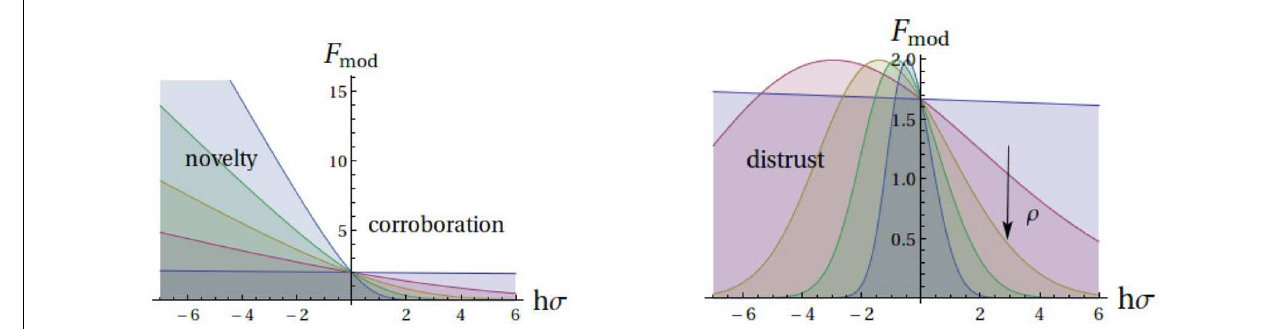
FIGURE 1 | The modulation function depends on a measure of novelty and on the number of social opinion exchanges. Left : Complete confidence on the information received. Right : Agent assumes noisy communication with received opinions randomly inverted with probability of 20 % . The vertical axes are modulation functions and horizontal axes represent agent prior opinion ( h ) times the sign ( σ ) of an opinion received in an exchange. Social interactions with opinions where